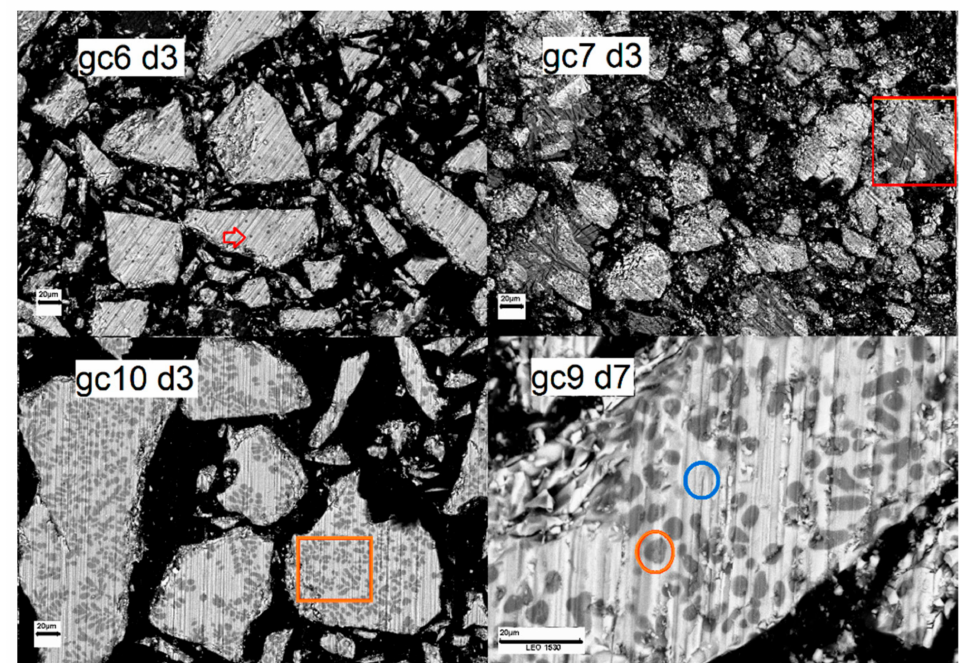
Figure 1. SEM (secondary electron) images of exemplar samples: gc6 ( up left ), gc7 ( up right ), gc10 ( down left ), and gc9 ( down right ) after immersion in SBF for 3 or 7 days. The scale bar, 20 µ m, reveals the magnification of the